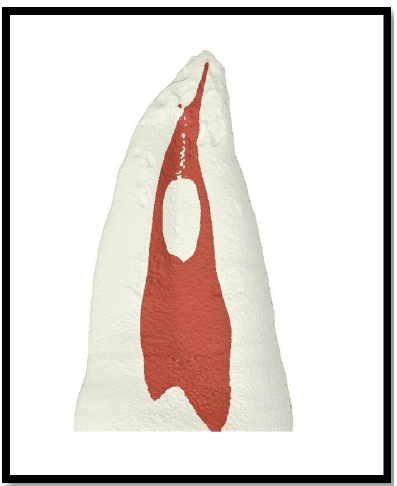
Figure 3. Micro-CT image showing Vertucci’s type III (1-2-1) canal configuration.